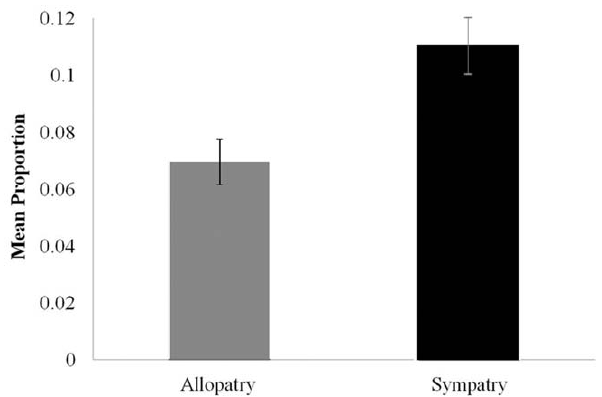
Figure 2. Mean (standard error) proportion of Thripstabaci that transmitted Tomato spotted wilt virus to indicator tissue in sympatric vector-isolate pairings versus allopatric vector- isolate pairings were significantly different (P